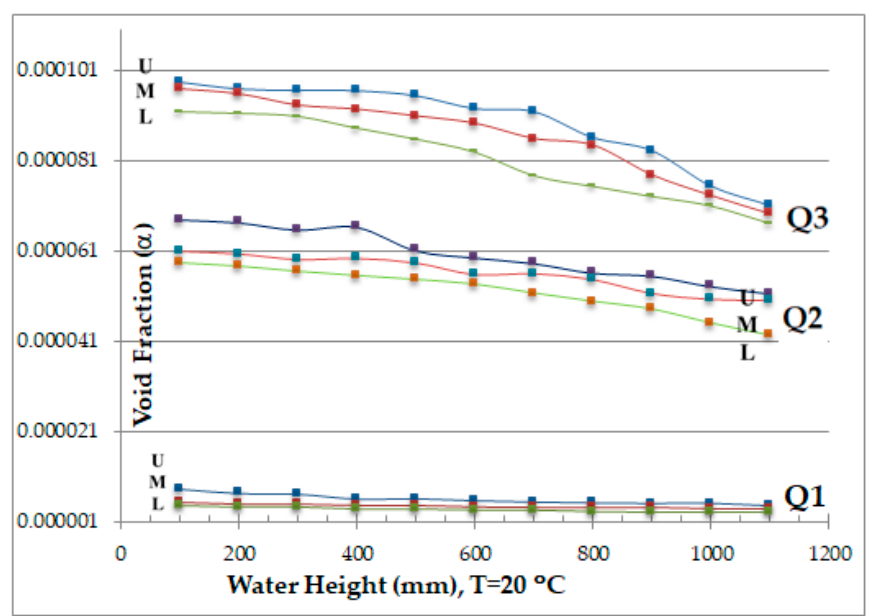
Figure 5. A sample of void fraction α as a function of water height for a water temperature of 20 ° C and for gas volume flow rates Q 1 , Q 2, and Q 3 .